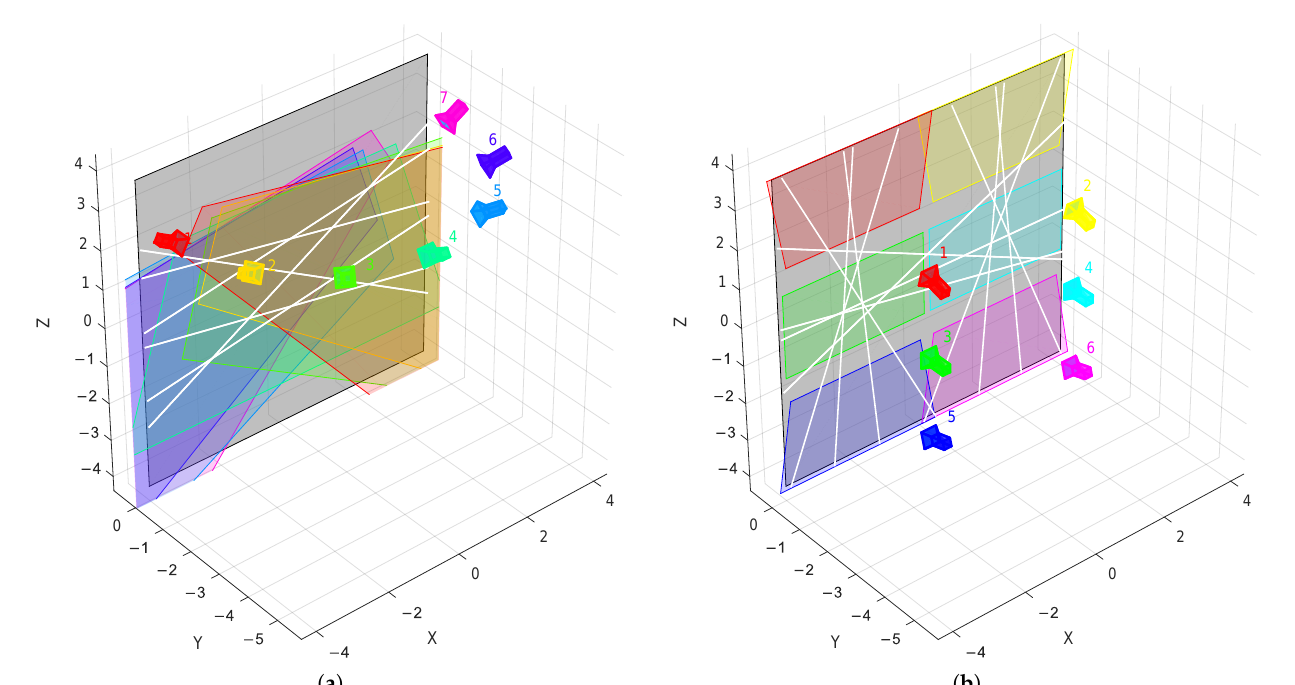
Figure 5. The two simulation scenes: ( a ) Scene with 7 overlapping cameras. ( b ) Scene with 6 non-overlapping cameras. The wall is shown in gray, the fields of view (FoV) of each camera is shown in its corresponding color, and the laser lines are shown in